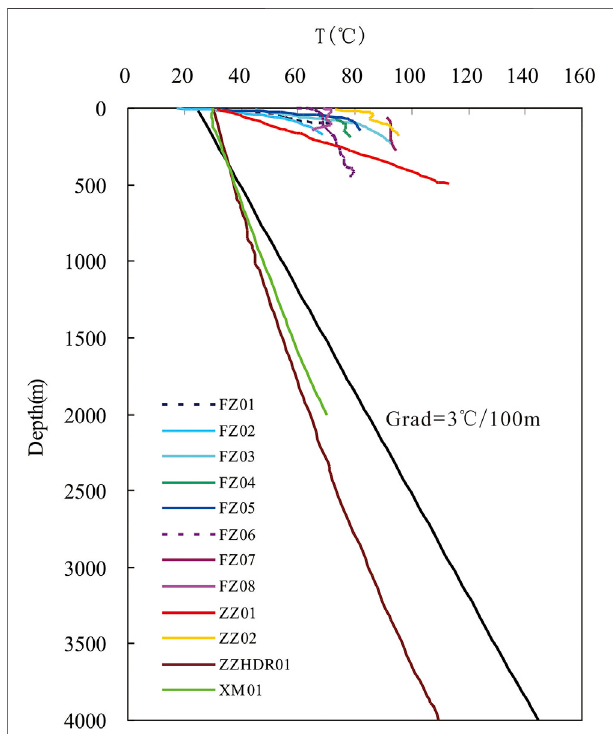
FIGURE 4 | Representative borehole temperature measurement curves for Fujian province. FZ01-08 refer to boreholes from the Fuzhou area, ZZ01-02 refers to boreholes from the Zhangzhou area, ZZHSR01 refers to the hot dry rock exploration wellbytheChinaGeologicalSurvey,XM01referstoexplorationwellintheXiamen area, the black line-geothermal gradient line with a global average value of 3 ° C/100 m